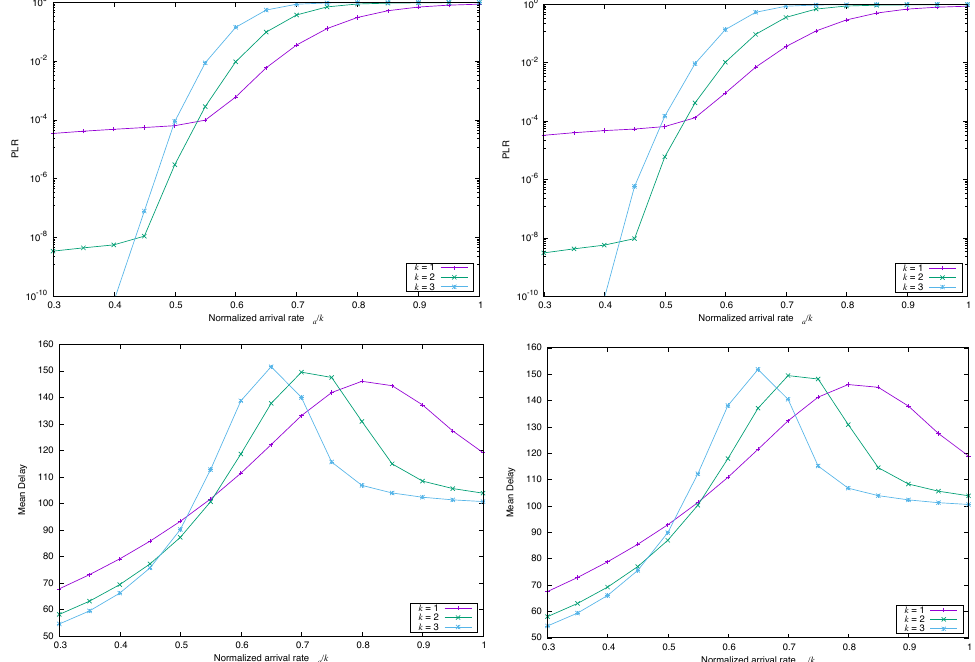
Figure 4. Simulated PLR ( top ) and Mean Delay ( bottom ) for FS-CSA versus λ a / k , with Λ ( x ) = 0.86 x 3 + 0.14 x 8 , n = 200 and k = { 1,2,3 } , and marginal distribution Poissonian ( left ) and Lognormal ( right ), in both cases µ = σ 2 .